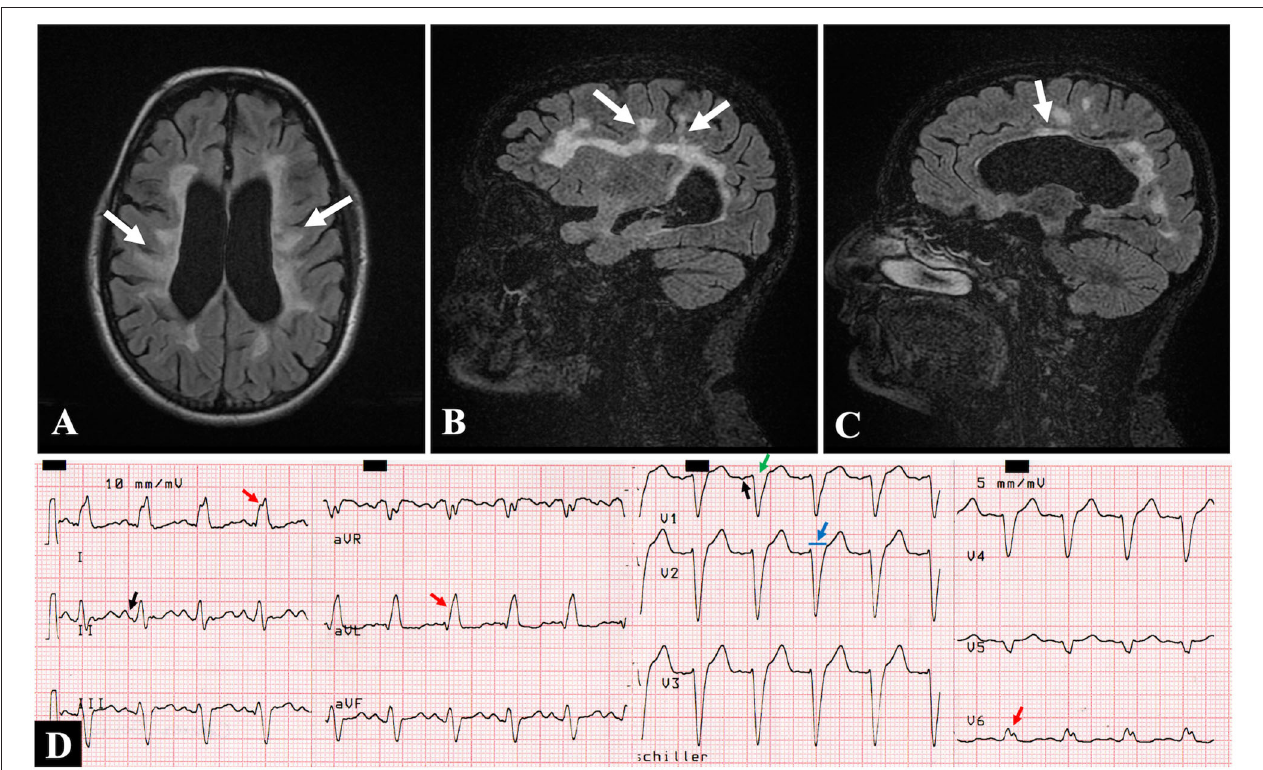
FIGURE 1 | Brain magnetic resonance imaging. (A) Axial and (B,C) sagittal views in FLAIR sequence showing demyelinating lesions consistent with multiple sclerosis: perpendicular to the lateral ventricles (A) , periventricular (B) , and corpus callosum (C) (white arrows). (D) Twelve-lead electrocardiogram showing sinus tachycardia (125 beats/min), left atrial dilatation [P mitrale in II, and deepening of the terminal negative portion of the P wave in V1 (black arrows)] and left bundle branch block [QRS duration of > 120ms (blue arrow), lead V1 with a dominant deep S wave (green arrow); broad, notched R wave in V6 and I, and monophasic R wave in aVL (red arrows)]. ms,